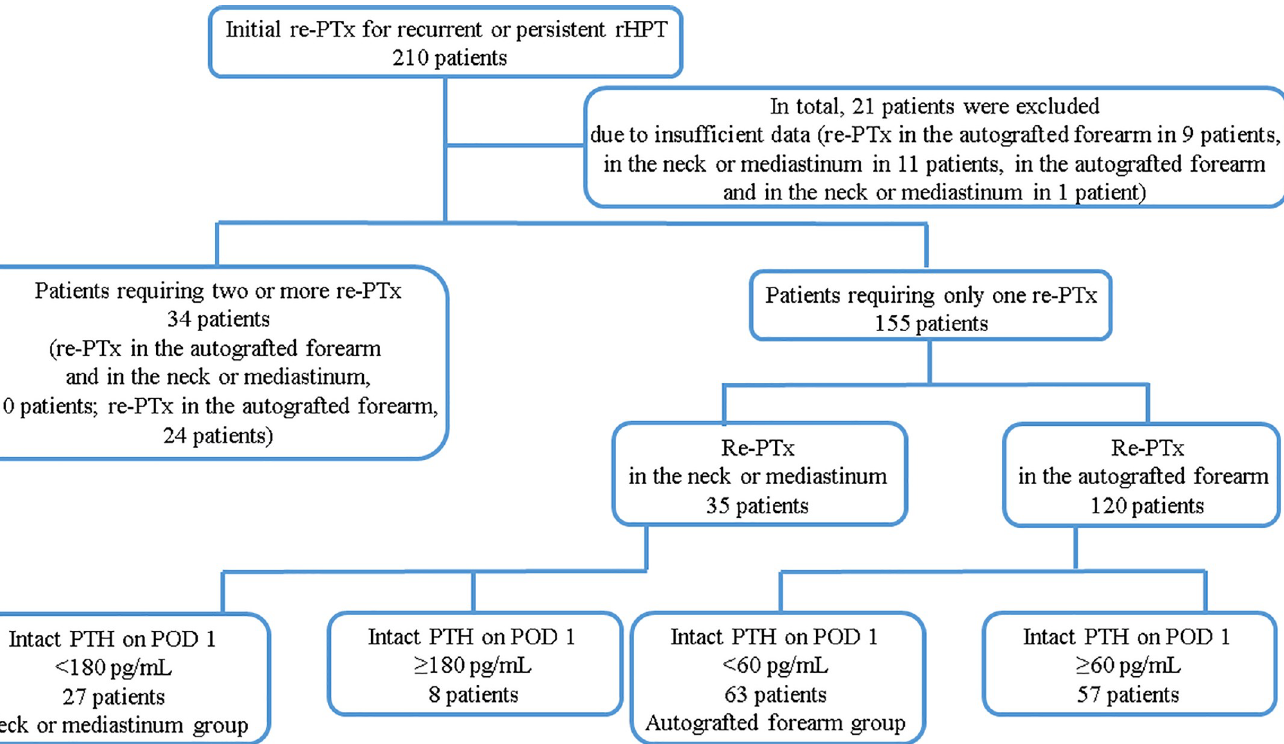
PLOS ONE | https://doi.org/10.1371/journal.pone.0248366 April 1,